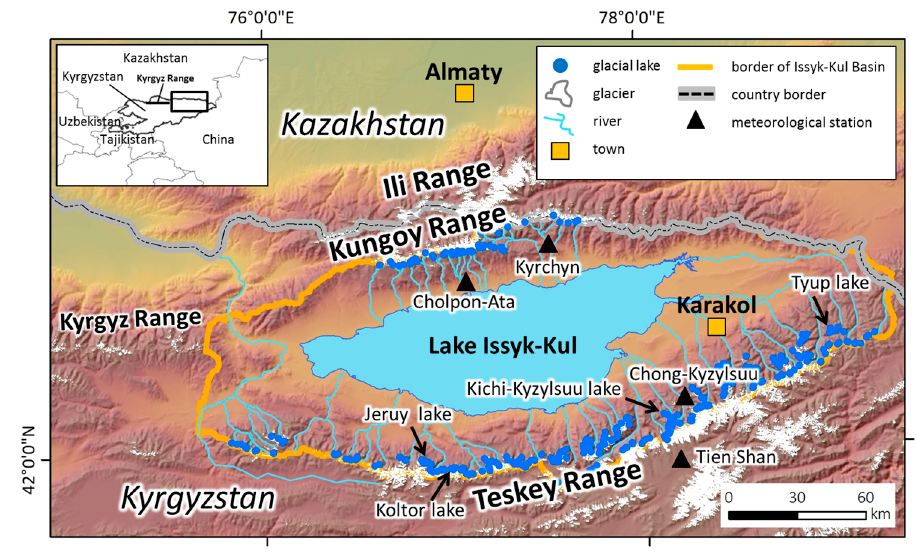
Figure 1. The Teskey and Kungoy Ranges in the Issyk-Kul Basin, Kyrgyzstan, and locations of existing glacial lakes (2016).